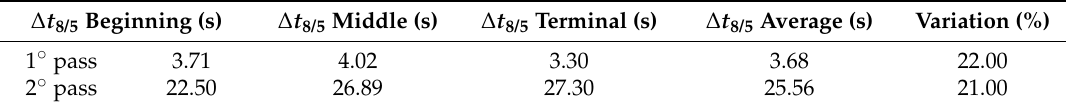
Table 4. Cooling time between 800 and 500 °C (∆ t 8/5 ) values at 0.002 m from the fusion line. ∆ t 8/5 Beginning